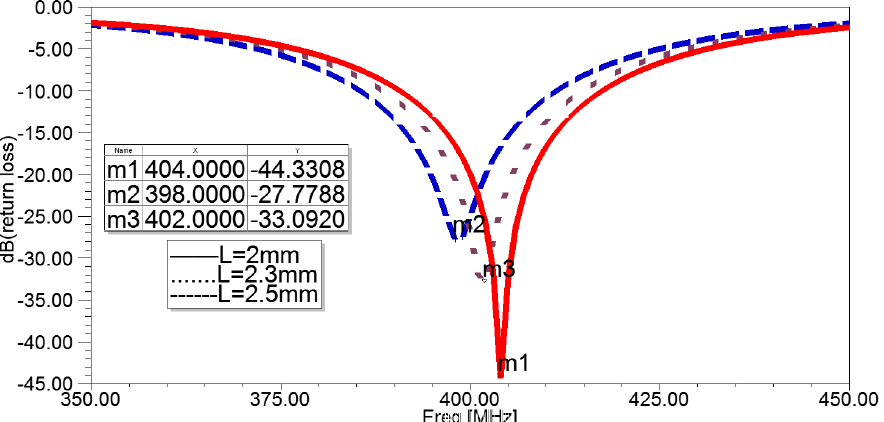
Figure 4. Return losses of the antenna in simulation setups according to different L